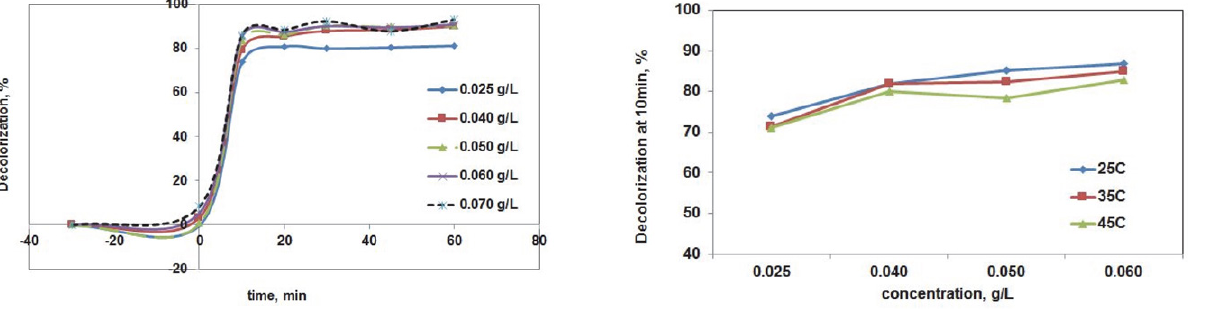
Fig. 8. Effect of temperature on the initial decolorization rate of DB- 22 (initial pH: original, H 2 O 2 amount: 2.78 g/L, m-ZZF amount: 3 g/L, CaCl 2 amount: 3.75 g/L, UV light)